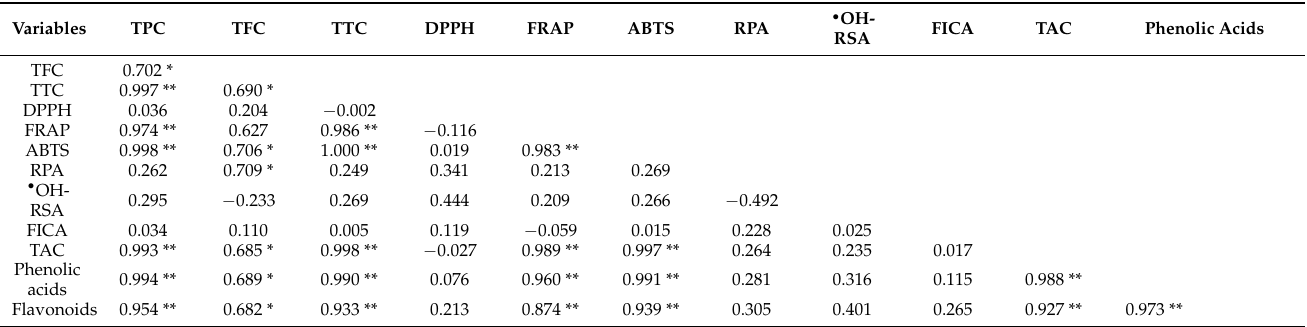
Table 3. Linear correlation coefficients ( r 2 ) for the relationships between phenolics and antioxidant assays.